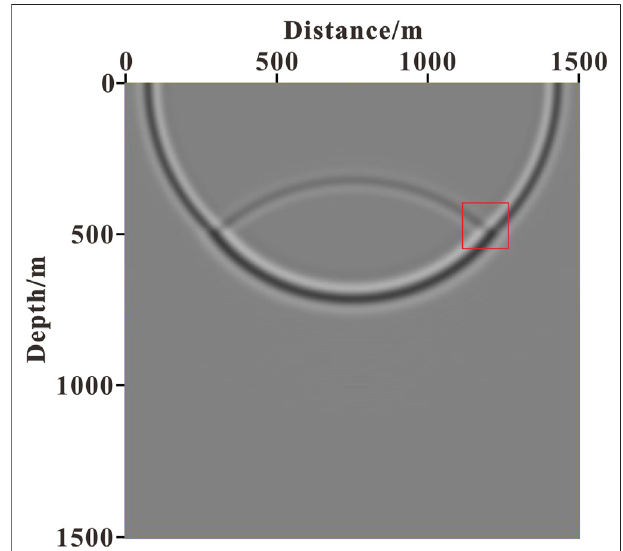
FIGURE 2 | The source wave fi eld snapshot at 0.3